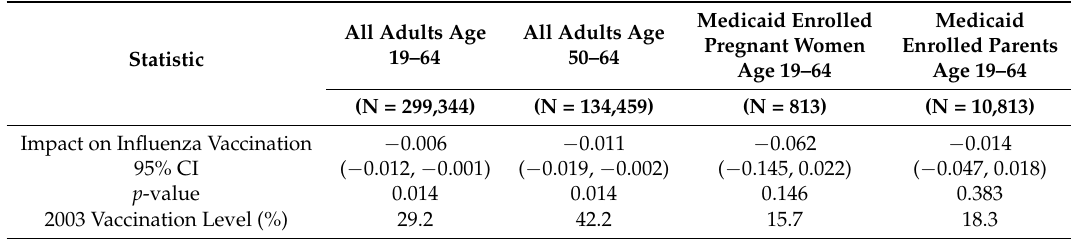
Table 4. Difference-in-difference impacts of copayment charges on influenza vaccination coverage for adults, 2003 vs. 2012 BRFSS